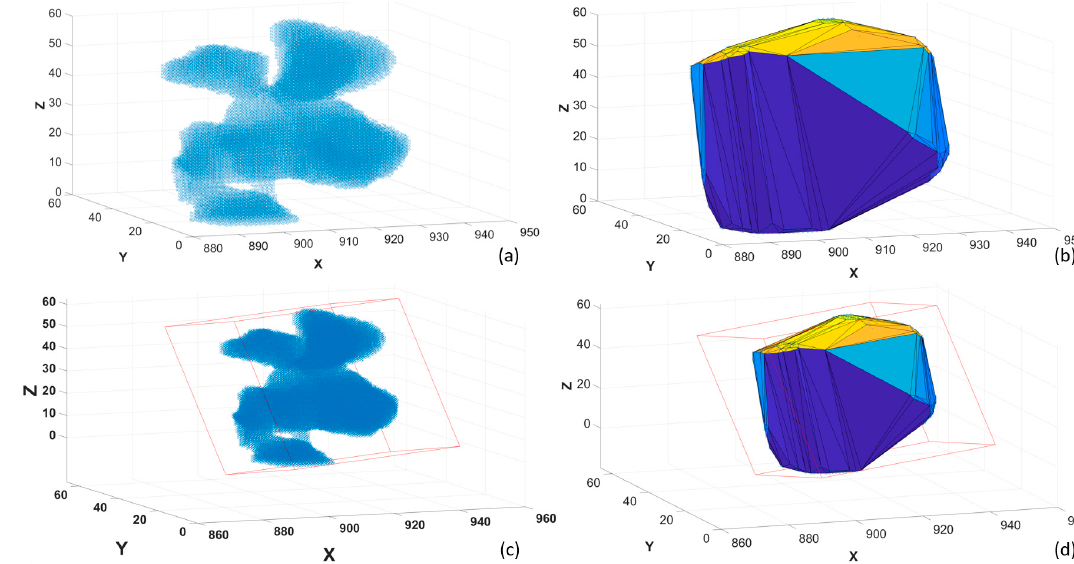
Figure 11. Using geometry to extract shape features of a particle. ( a ) Scatter plots representing the particle; ( b ) convex hull of the particle; ( c ) minimum volume bounding box of the particle, which is the same as the bounding box for the convex hull ( d ). From the convex hull, convex surface area and solidity (ratio of convex volume and actual volume of a particle) can be obtained, while from the bounding box, major, intermediate, and minor dimensions of the particle can be obtained.